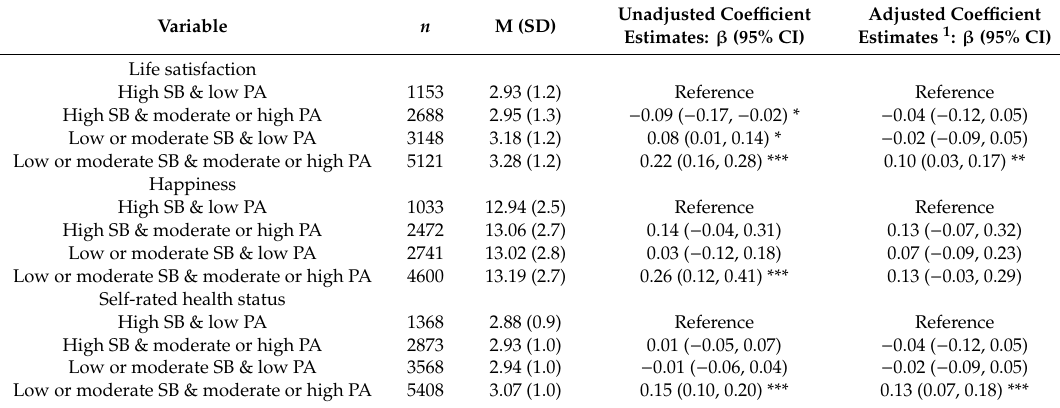
Table 3. Combined associations of sedentary behaviour and physical activity with life satisfaction, happiness and perceived health